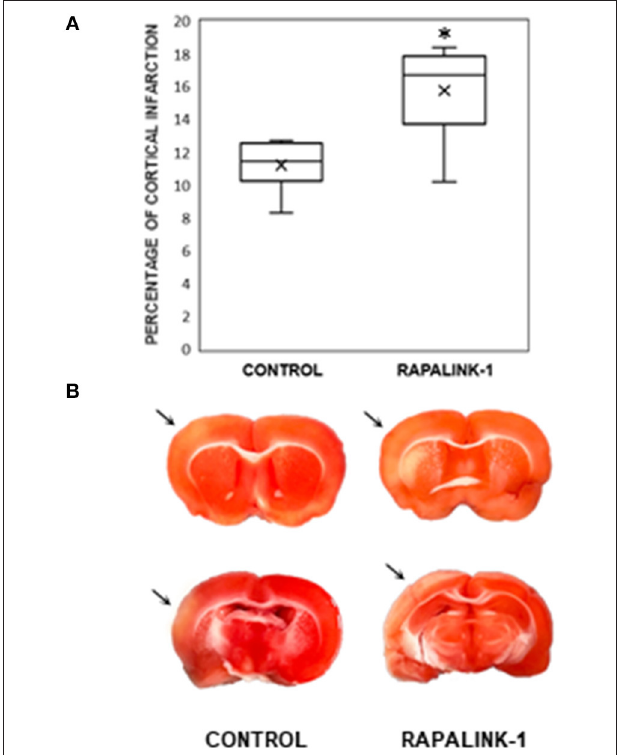
FIGURE 3 | (A) A diagram with box plots showing the percentage of cortical infarcted area compared with total cortical area in the experimental groups after 1h of MCAO and 2h of reperfusion. Each boxplot consists of 25th percentile, median, 75th percentile, and whiskers with the minimum and maximum. Mean is shown with the symbol “ × .” Rapalink-1 increased the percentage of the cortical infarct out of the total cortical area. n = 6 in each group. An unpaired Student’s t -test was used for the significance. * p < 0.005 vs. the control group (MCAO/reperfusion). (B) Two representative brain sections from the similar brain regions of the control group (MCAO/reperfusion) and the Rapalink-1 group (MCAO/reperfusion + Rapalink-1). The tissue samples were photographed at 2h after reperfusion without any fixatives. The area of the infarcted cortex appeared pink, not white, which suggests infarction is still going on. The infarcted cortices are marked with arrows. Some of the subcortical areas appeared to be